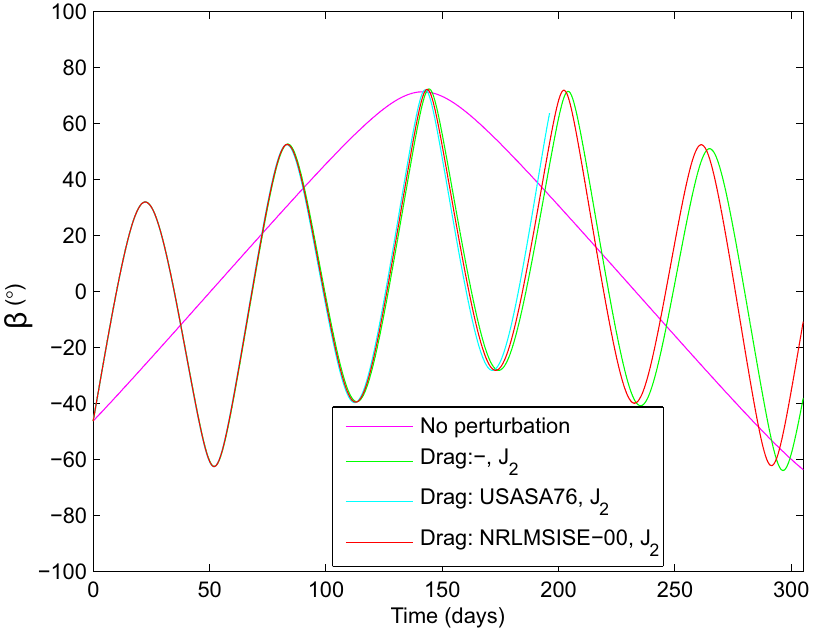
Figure 9. β angle along one year for TLE1 with different perturbation